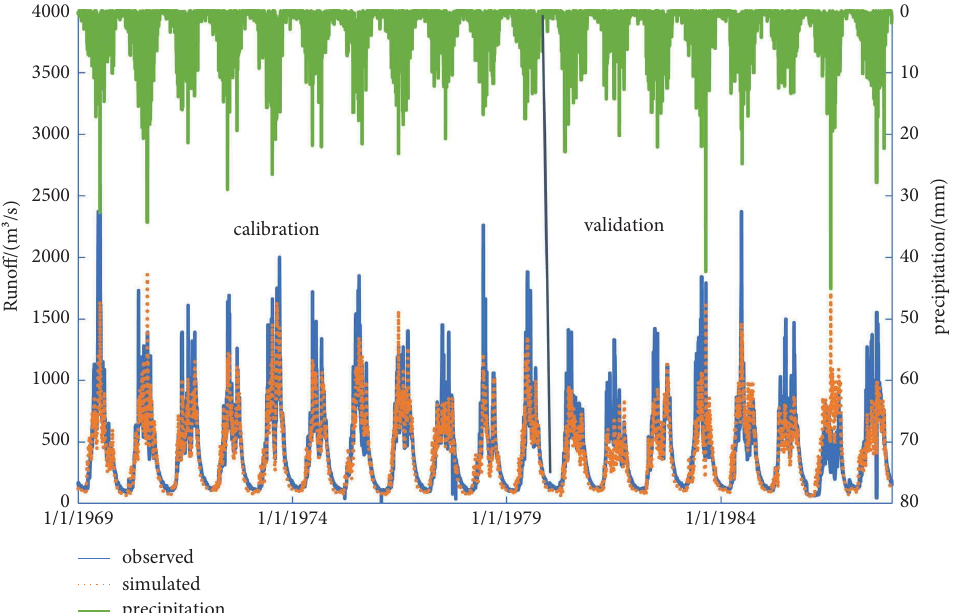
Figure 3: Daily runof hydrograph of the Zipingpu hydrometric station during calibration and verifcation period.